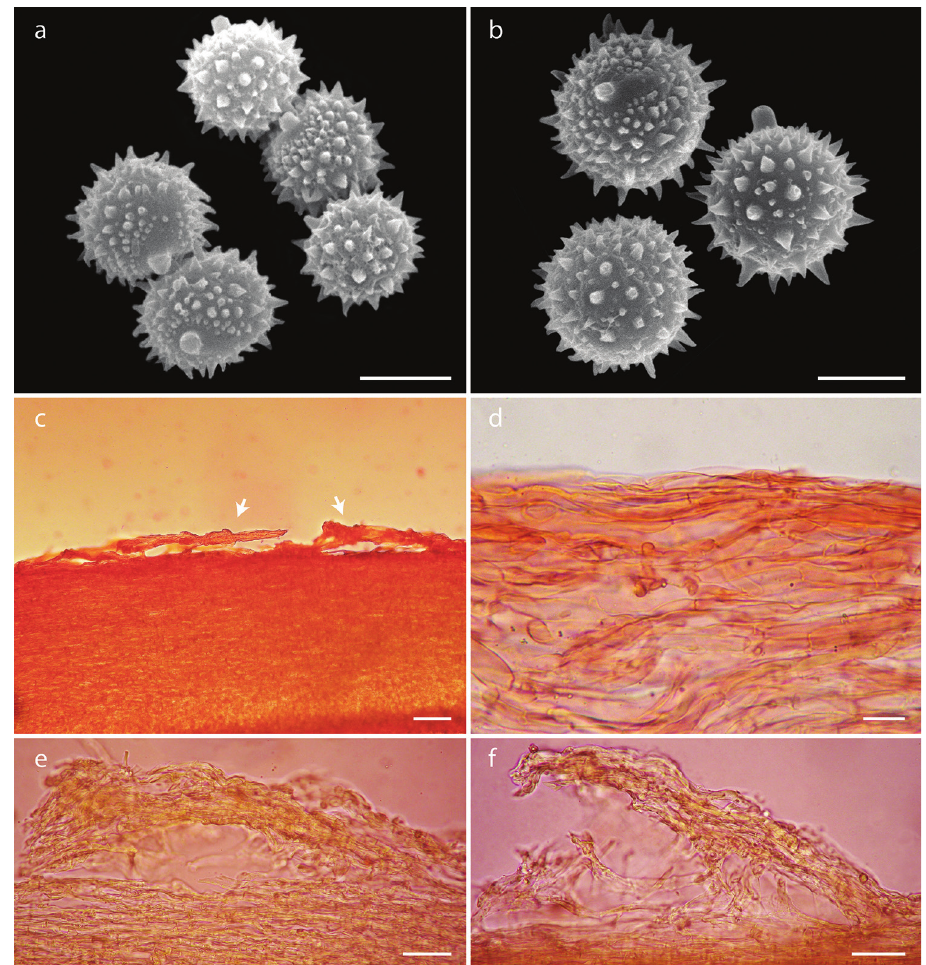
Figure 5. Laccaria squarrosa , a–b basidiospores under SEM c–f details of the pileipellis c–d cutis (arrow indicating scales) e–f details of the pileipellis scales c–f DM 63 (holotype). Scale bars: 5 µm ( a ); 2 µm ( b ); 100 µm ( c ); 20 µm ( d ); 50 µm ( e–f ).